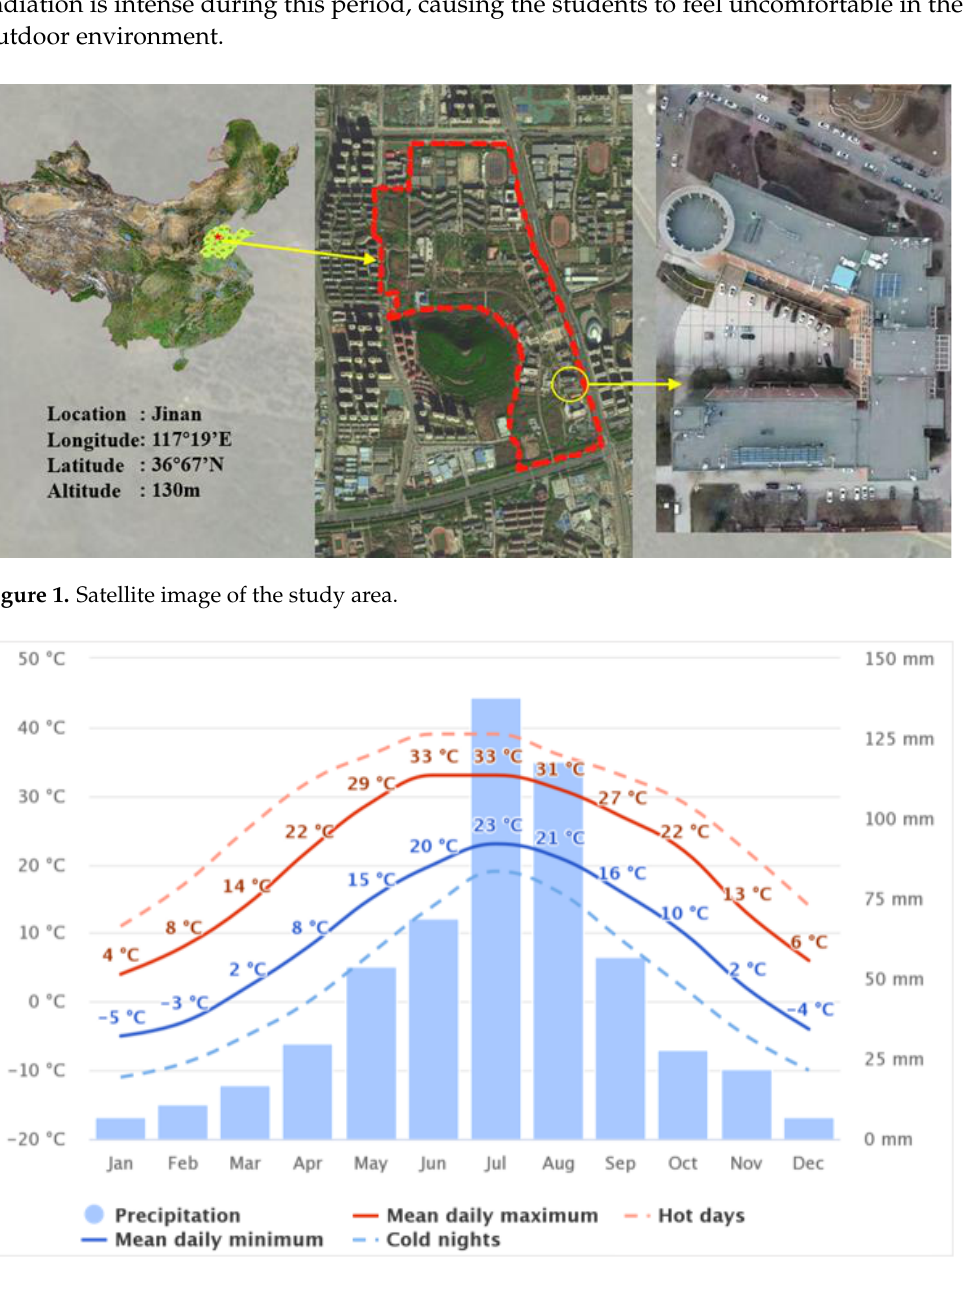
Figure 2. The monthly mean climatic data for Jinan city during a 30-year period obtained from Me- teoblue (2022)